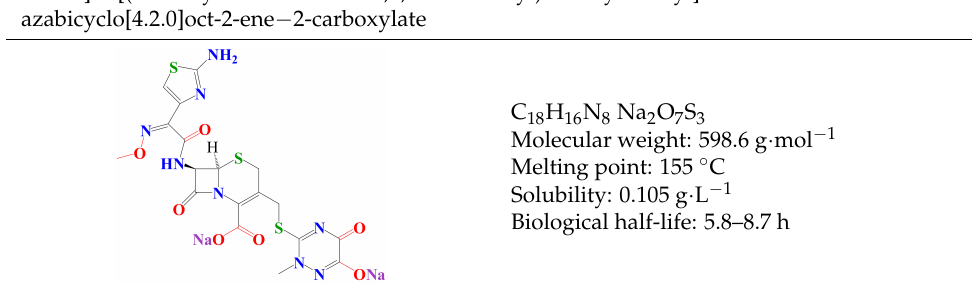
Table 1. Physical properties of ceftriaxone